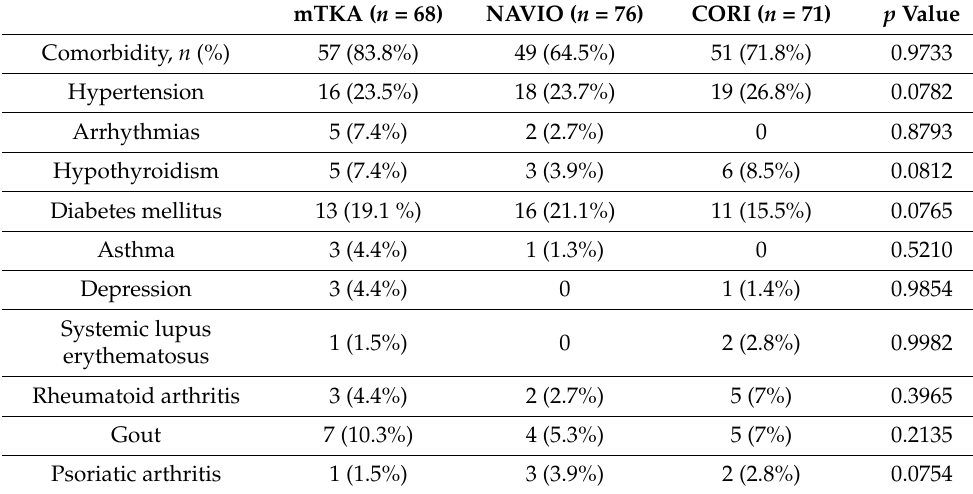
Table 2. Comorbidities among the study